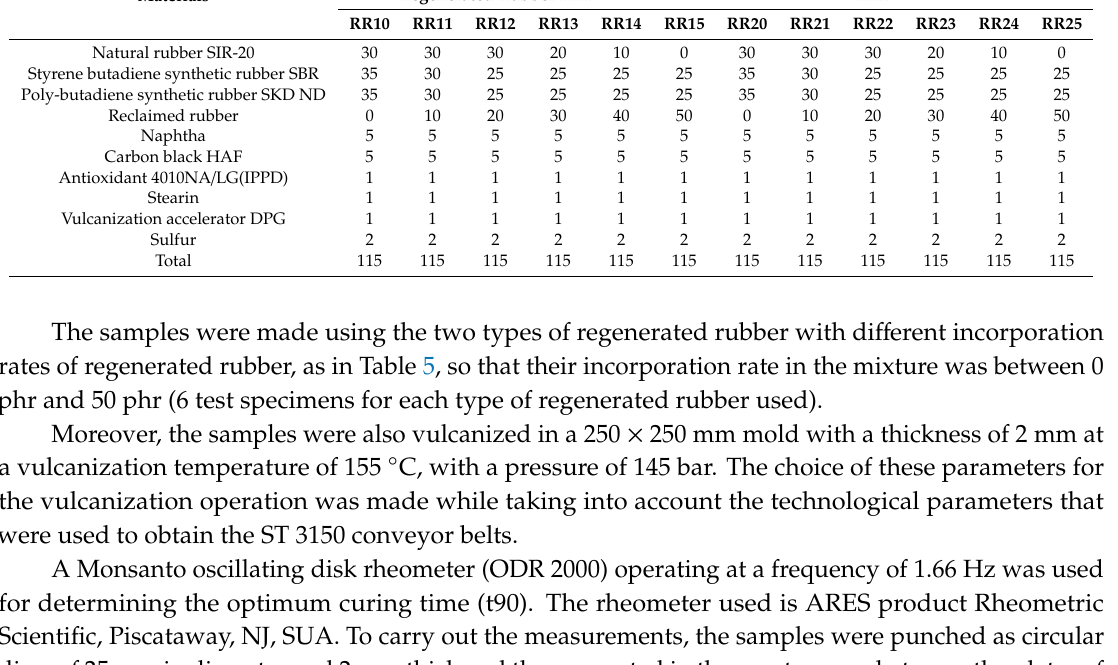
Table 5. Composition of the rubber mixture made of the two types of regenerated rubber, phr. Samples Made with the Use of Regenerated Rubber RR1 Materials